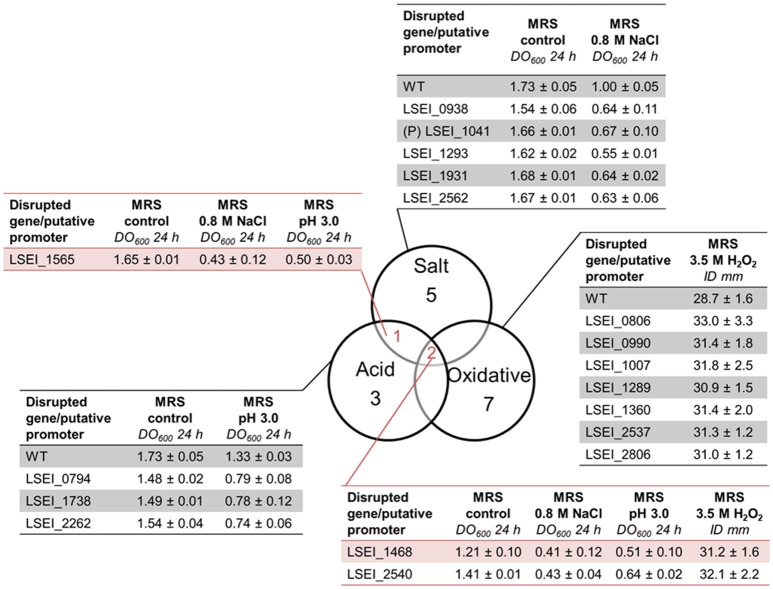
Venn diagram of L. paracasei mutants sensitive to salt (0.8 M NaCl, 24 h), acid (pH 4.5, 24 h), and/or oxidative (3.5 M H2O2, 24 h) mild stresses, their corresponding OD600 24 h and their inhibition diameters (ID). (P), putative promoter. The predictive function of each gene is reported in Table 5.